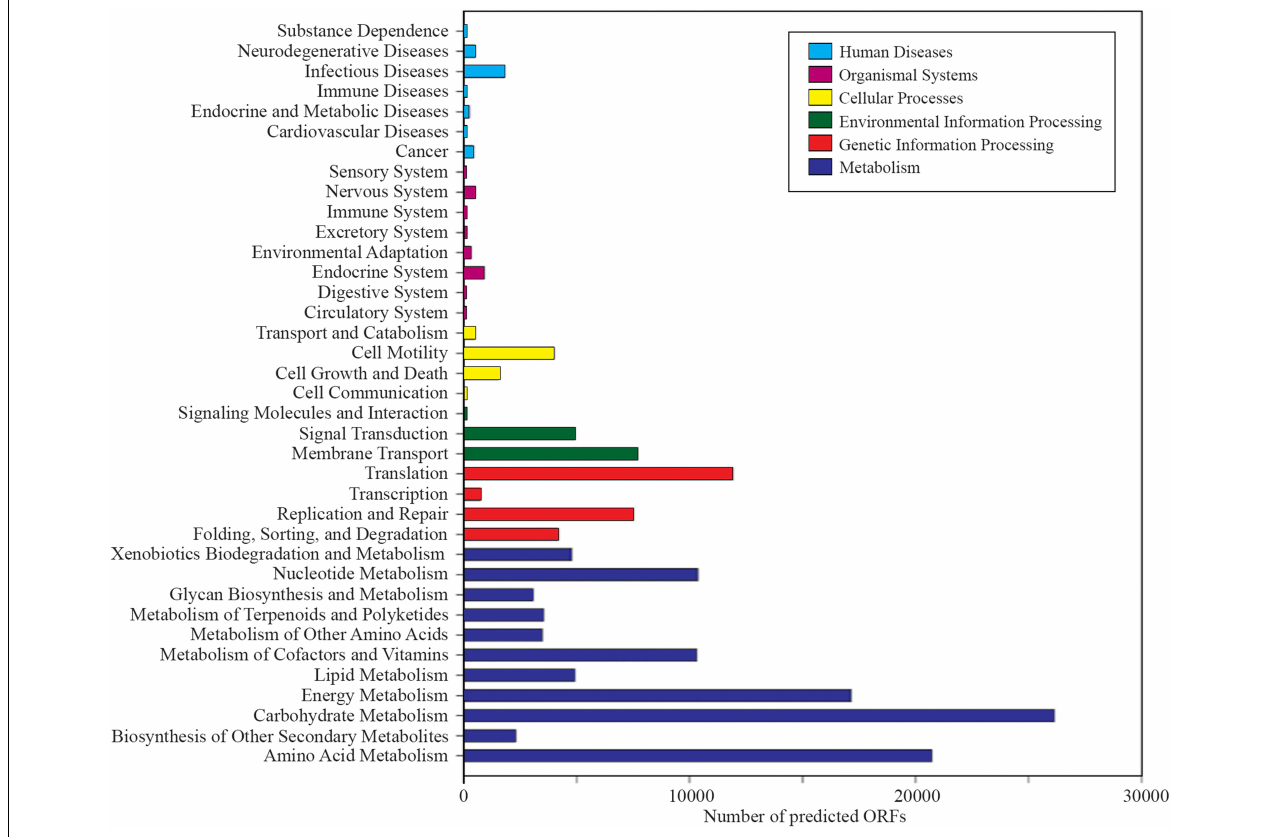
FIGURE 5 | Number of predicted ORFs that matched metabolic categories, based on KEGG